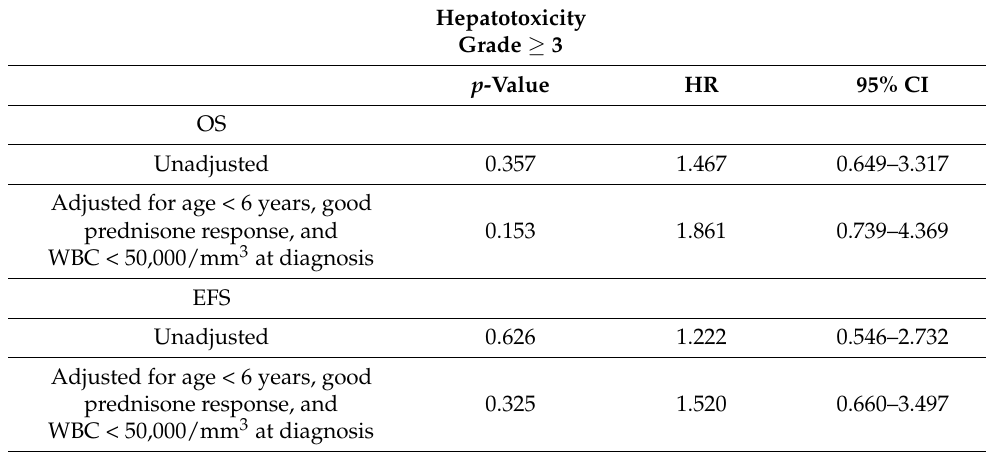
Table 5. Multivariate Cox regression analysis of the impact of grade ≥ 3 hepatotoxicity on outcome.